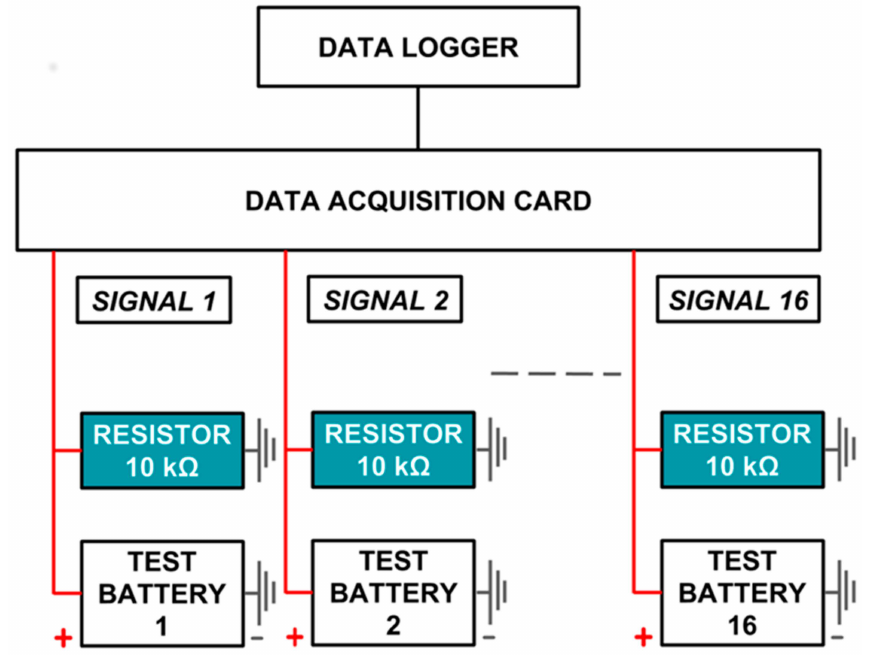
Figure 2. Schematic of data acquisition